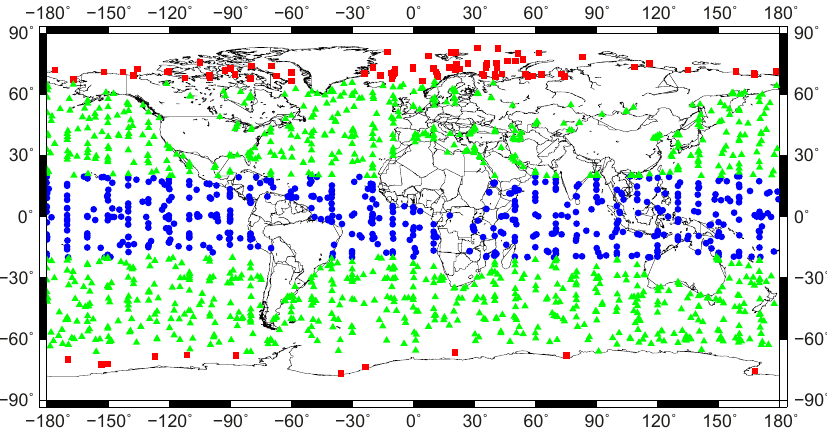
Figure 7. Localisations of the 1681 simulations considered for running 1D-Var inversions by latitude bands: 91 for polar latitude as red squares, 1068 for mid-latitudes as green triangles and 522 for tropical latitudes as blue